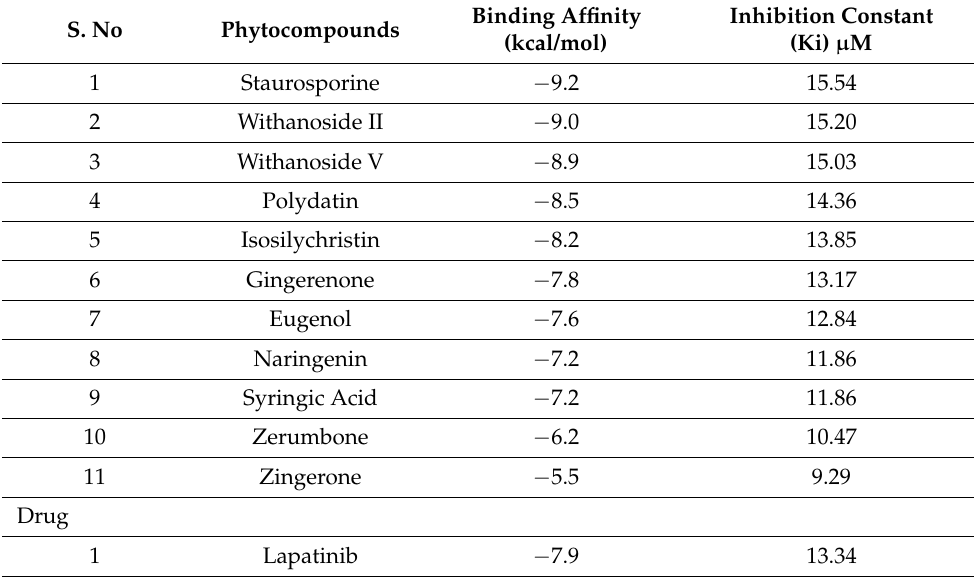
Table 1. Binding affinity (kcal/mol) of natural